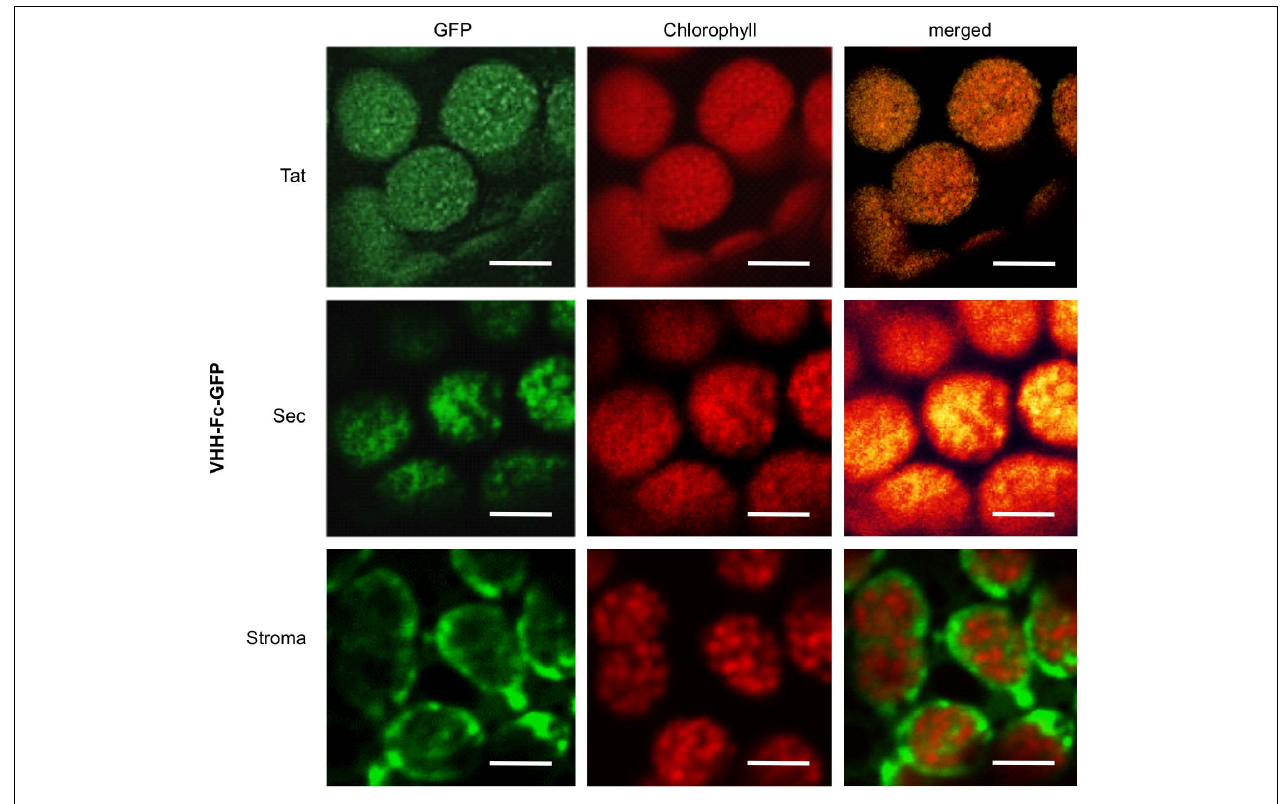
FIGURE 3 | Sec and Tat transit peptides enable localization of the recombinant Fc-GFP to the thylakoid chloroplast sub-compartment. Confocal images visualizing GFP-tagged Fc (green) targeted to the chloroplasts with either Sec, Tat or stromal signals. Chlorophyll (red) indicates the locations of the thylakoid grana. Fluorescence was sequentially captured, and the merged images show co-localization of GFP and chlorophyll (yellow). Size bar = 10 µ